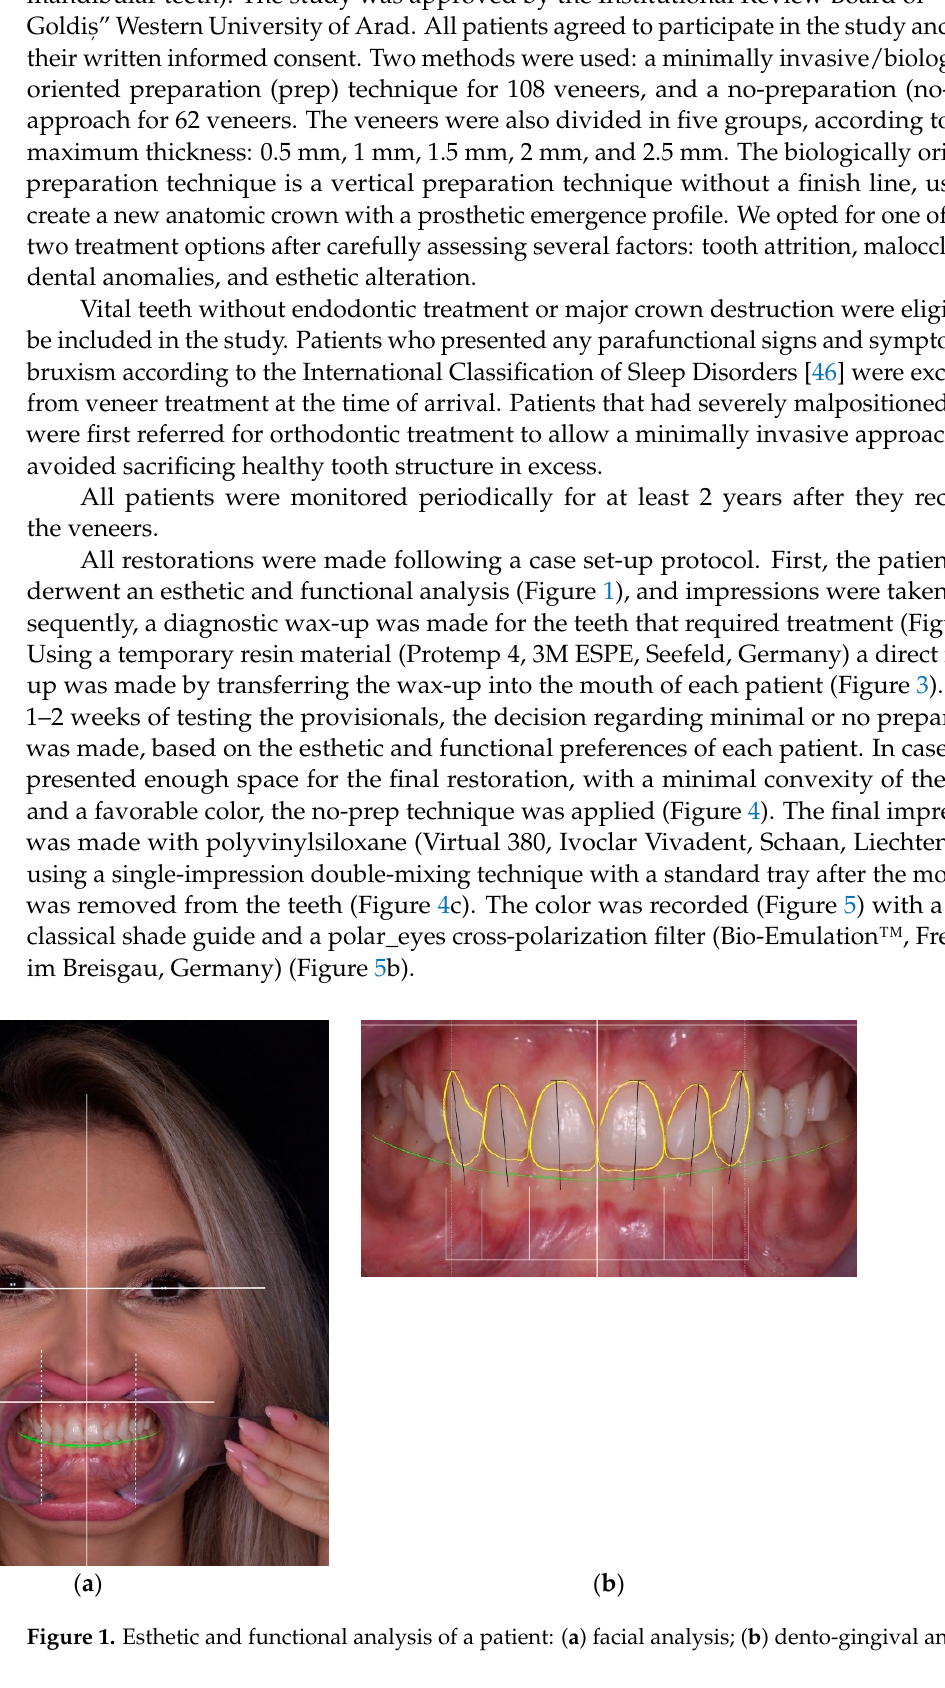
Figure 2. Diagnostic wax-up in which minimally invasive corrections with wax have been made. In all cases, the first option was an additive wax-up instead of substrative. ( a )